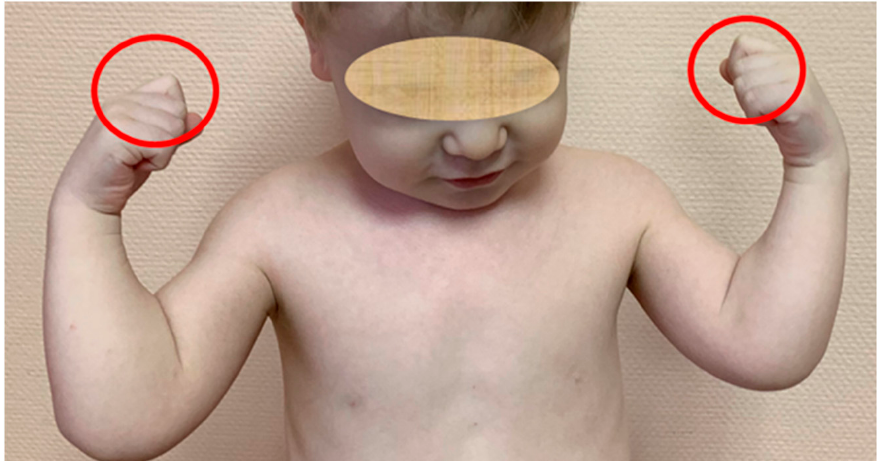
Figure 2. Early clinical hallmark of MED type 4—limited flexion in the second metacarpophalangeal joint, resulting in the “index sign” when the fingers are clenched into a fist (red circles).